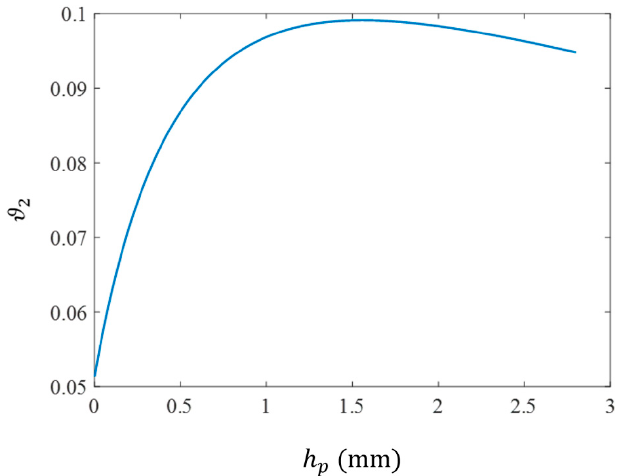
Figure 13. Mean value of the harvested power versus the thickness of the piezoelectric layer, when (cid:1844) (cid:3039) = 0.2 MΩ.